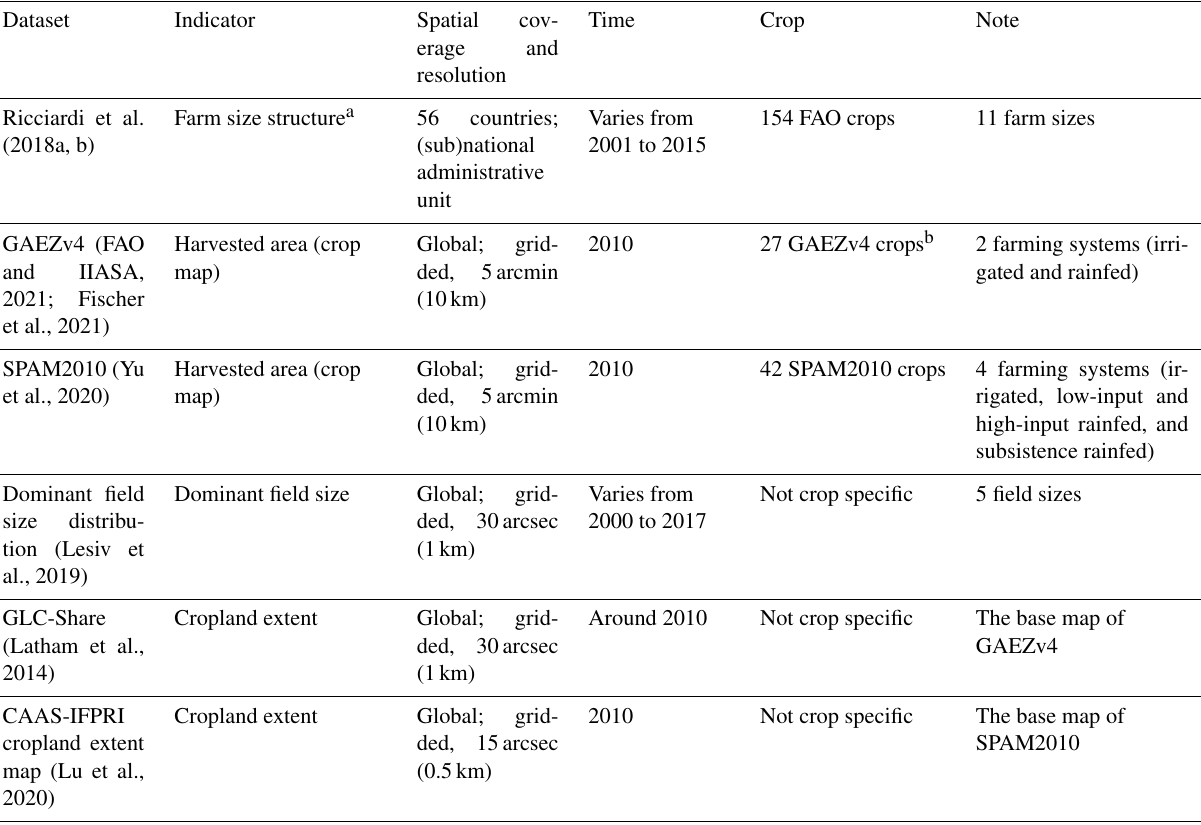
Table 1. Datasets that were used to develop the gridded, farm-size-specific and crop-specific datasets of harvested areas. Dataset Indicator Spatial cov- Ricciardi et al. Farm size structure a 56 countries;